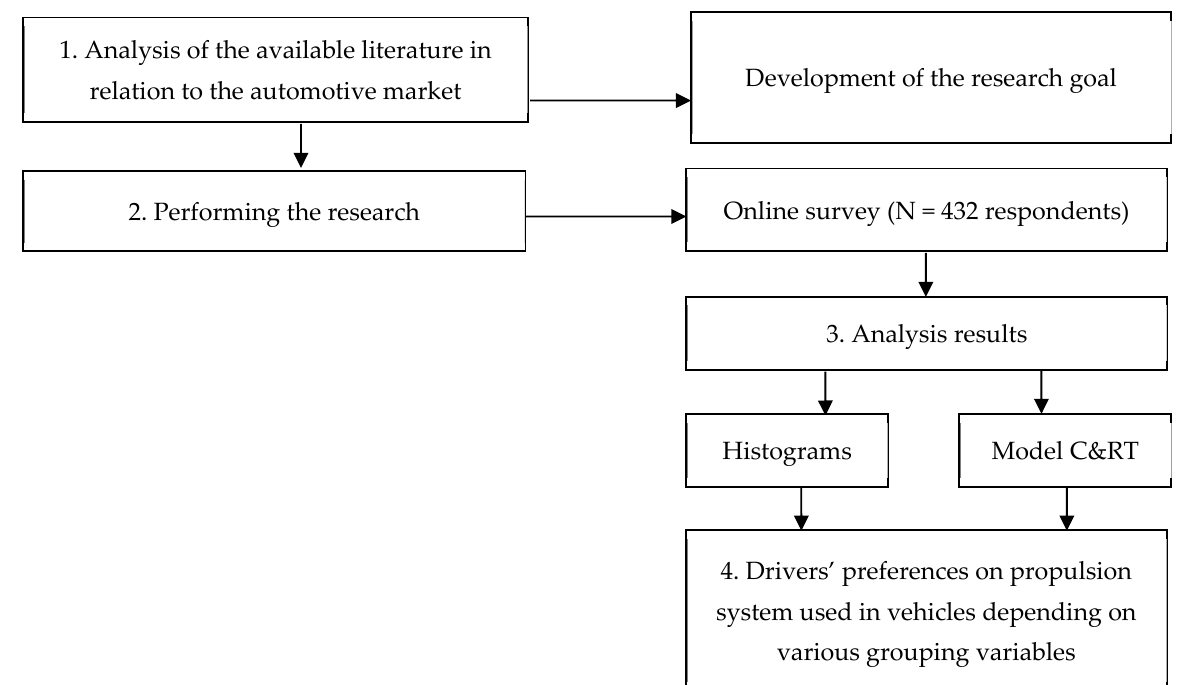
Figure 2. Flow chart of the methodology of the overall study.